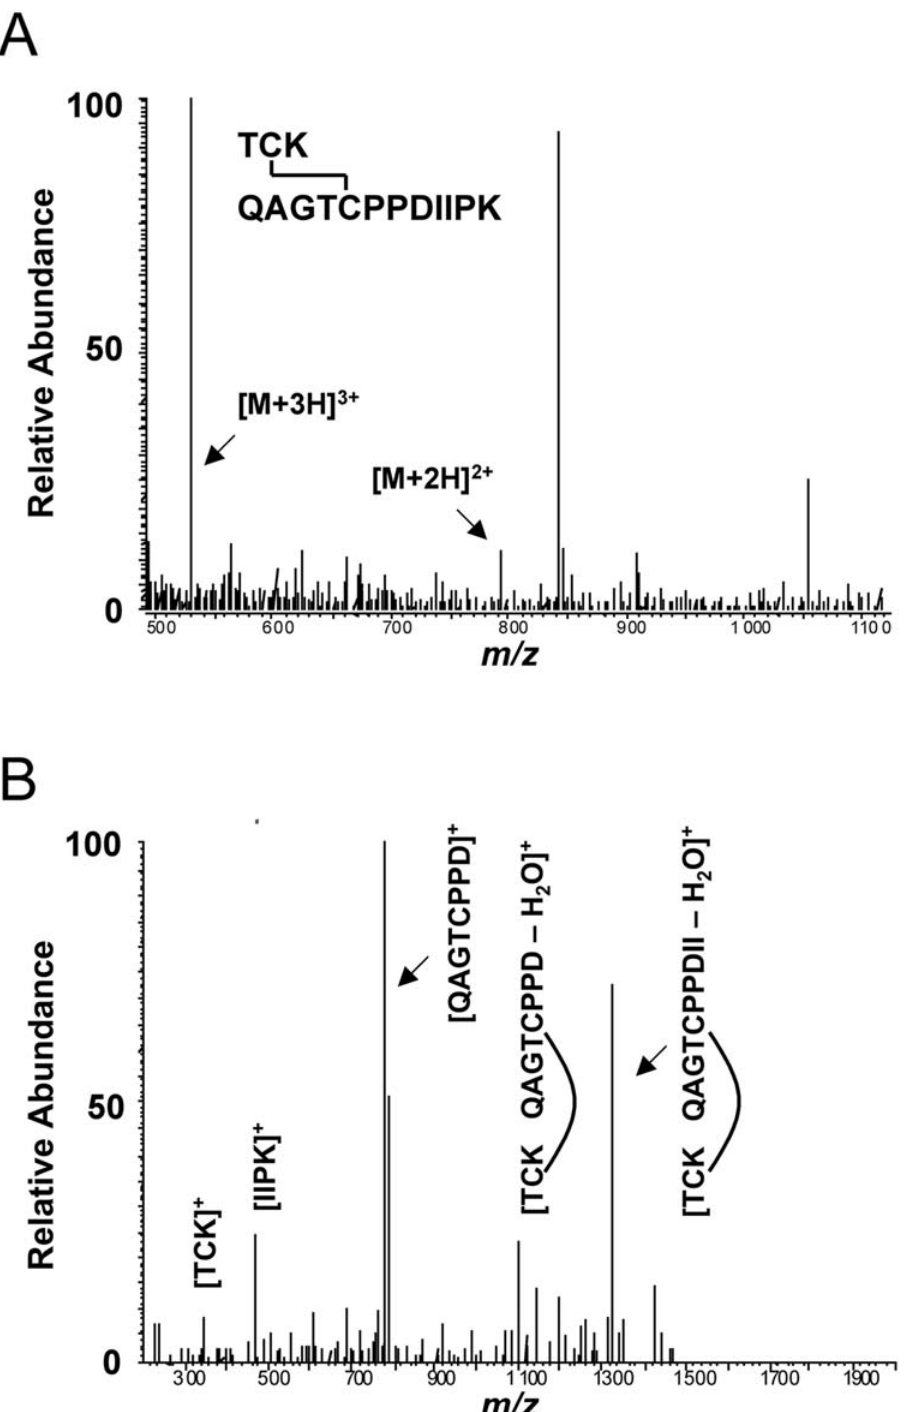
Figure 4. Mass spectrometry of non-reduced L2 protein. (A) The full MS spectra of the L2 tryptic peptides T21-K23 and Q24-K35 with C22–C28 disulfide bond intact. The predominant doubly charged and triply charged parent cations are evident. (B) The MS/MS spectra of the doubly charged precursor ion and assignment of internal fragments. Upon collisional activation the disulfide bond was broken, but two major non-reduced species are evident. The non-reduced species were preferentially fragmented at I32 and P34. doi:10.1371/journal.pone.0004463.g004 accessible surface location; although L2 and histones are labeled, is likely to reflect L1, and this signal may persist even if L1 is levels are significantly lower (unpublished observations). The proteolytically degraded. To examine the fate of the capsid proteins during cell entry and trafficking, cells were exposed to majority of the AF594 signal in microscopy experiments therefore